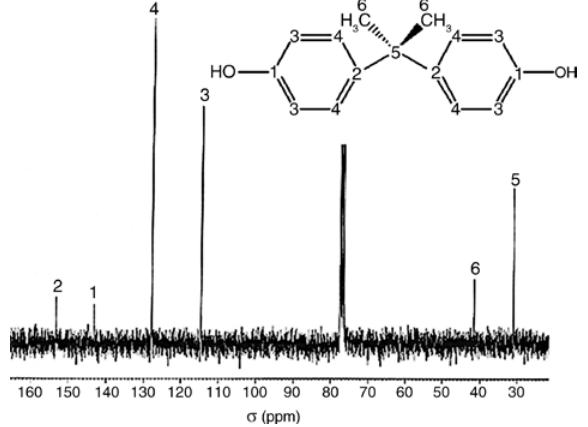
Scheme 7: 1 H NMR spectrum of recovered pure BPA in the CDCl solvent.